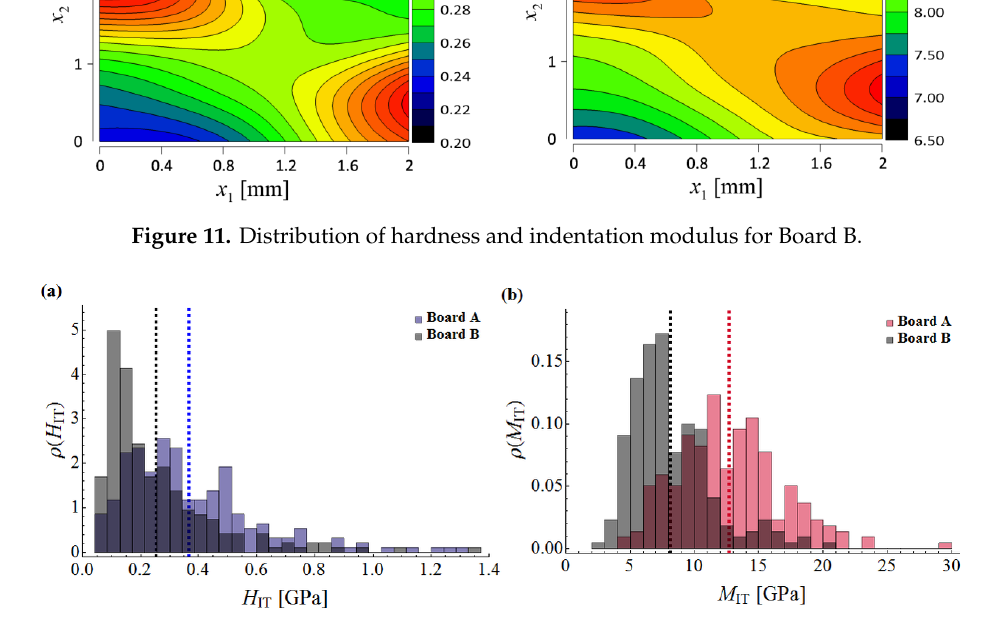
Figure 11. Distribution of hardness and indentation modulus for Board B.